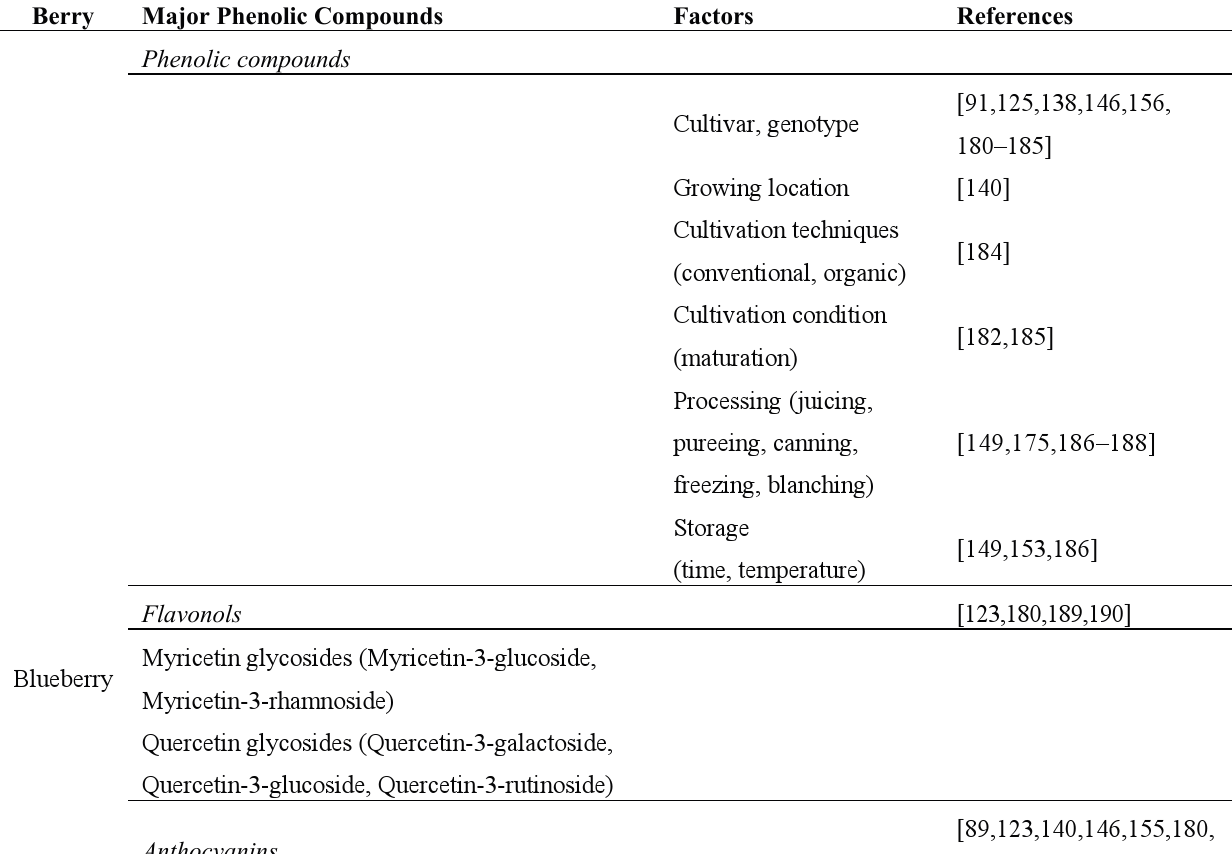
Table 4. Phenolic composition and factors influencing the composition of